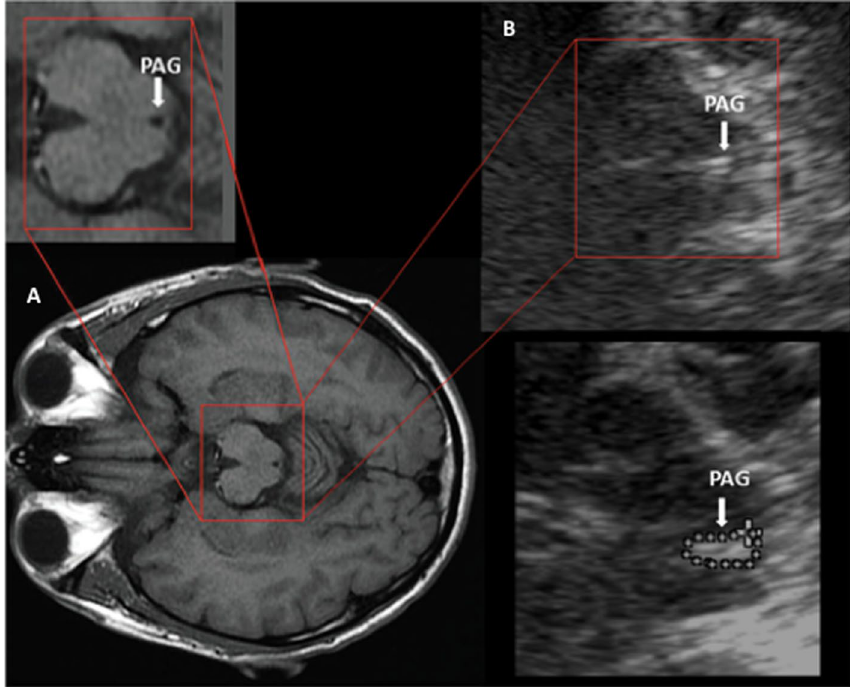
Fig. 1 Magnetic resonance and transcranial sonography images of midbrain axial sections showing the periacueductal gray matter. The TCS images show images from our sonographic laboratory obtained with an ultrasound system for clinical application (Philips Affiniti 70 ultrasound machine). A MRI of the axial section at the level of the midbrain. The square box shows the area corresponding to the magnified TCS image shown in B. B TCS image of the axial midbrain section showing the area of the periaqueductal gray matter